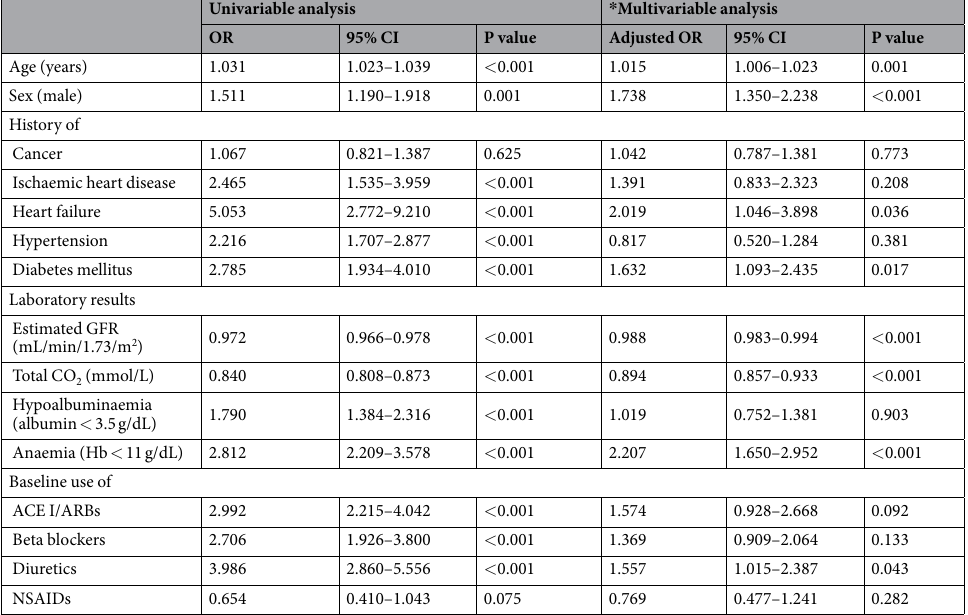
Table 4. Factors associated with mild hyperkalaemia (K + 5.1–5.5 mmol/L). OR, odds ratio by logistic regression analyses, CI, confidence interval, GFR, glomerular filtration rate, CO 2 , carbon dioxide, Hb, haemoglobin, ACE I, angiotensin converting enzyme inhibitor, ARB, angiotensin receptor blocker, NSAID, non-steroidal anti-inflammatory drug. Those with overt hyperkalaemia (K + > 5.5 mmol/L) were not